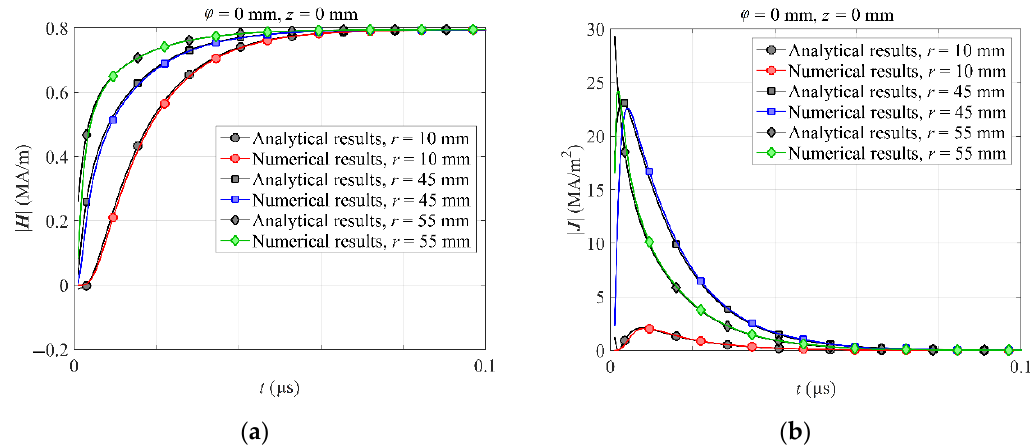
Figure 3. The absolute values of: ( a ) the magnetic field H and ( b ) the eddy current J vectors; as a function of time t for different values of parameter r , φ = 0 ° .